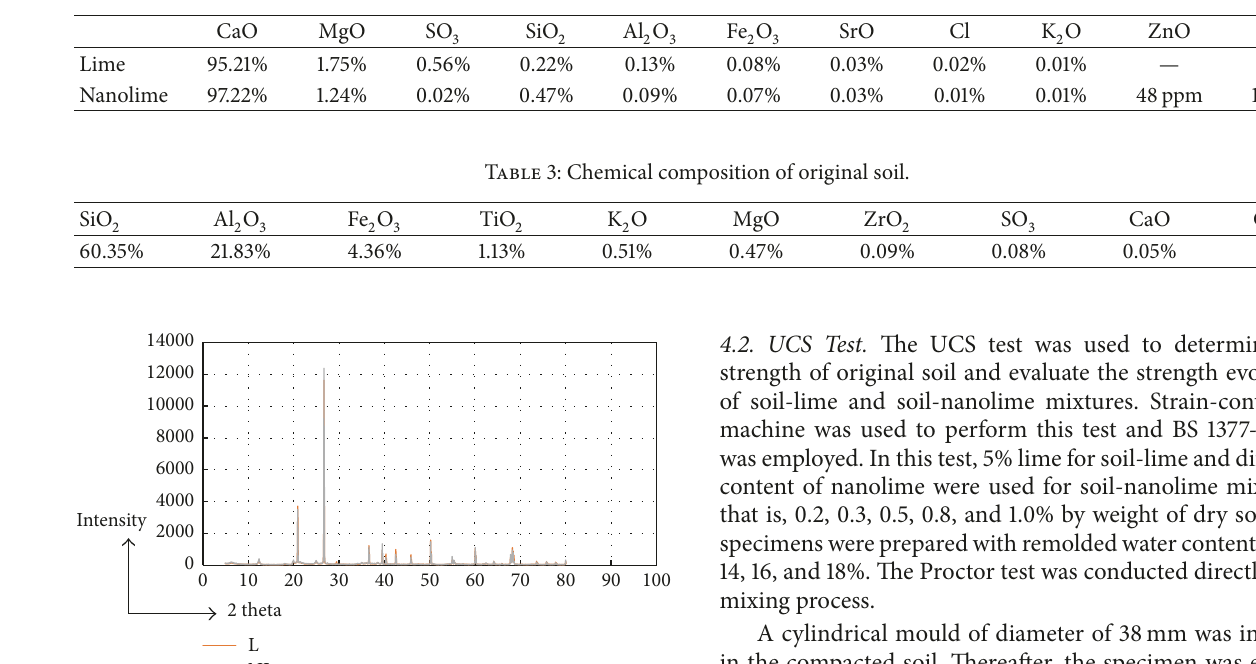
Table 2: Chemical composition of lime additive.